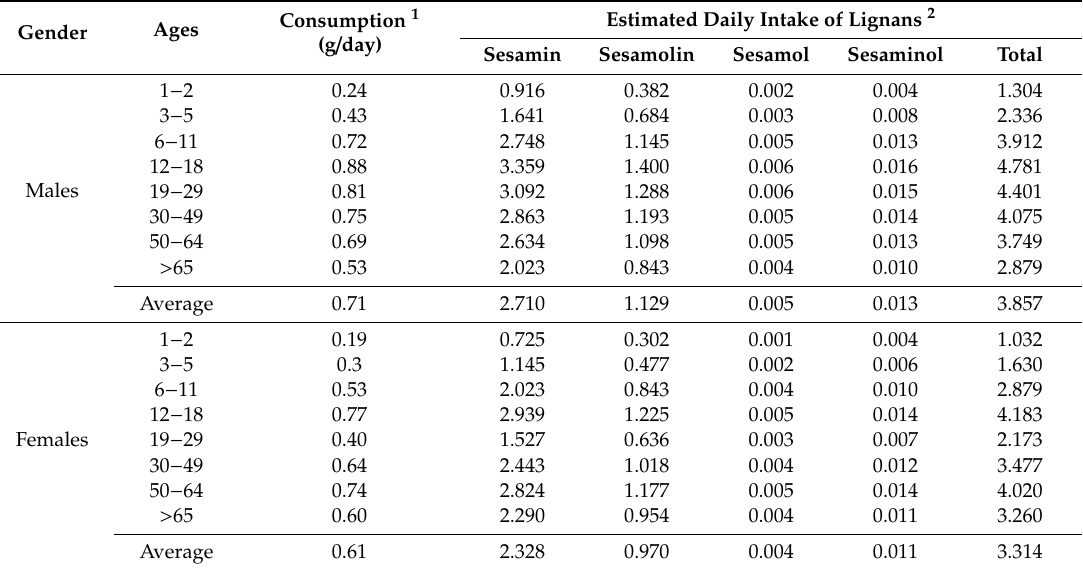
Table 5. Estimated daily intake (EDI) of lignans from sesame seeds (mg / person /